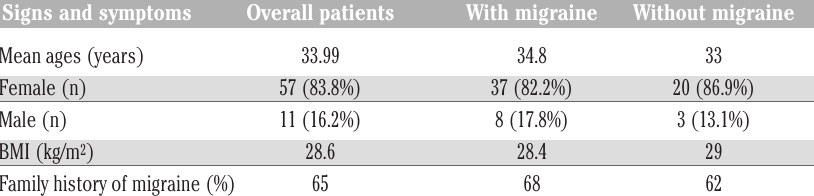
Table 1. Overall information about the patients studied. Signs and symptoms Overall